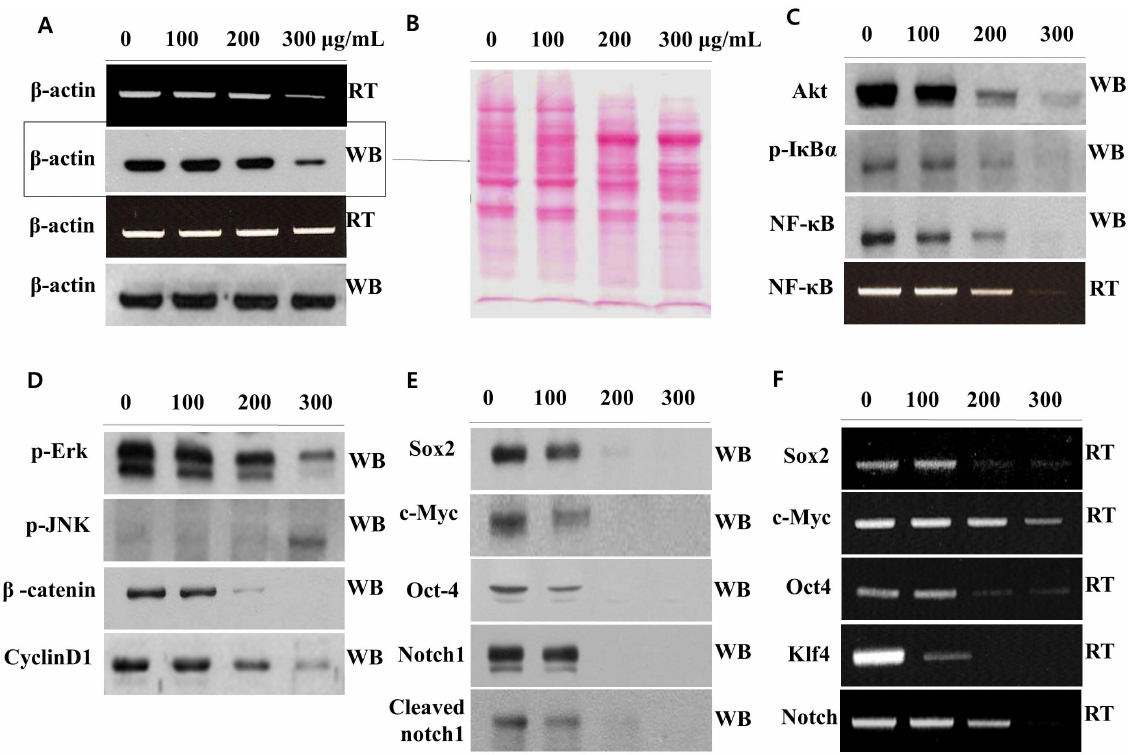
Figure 5. Western blot analysis. Cells were grown for 48 h after MOL treatment and their protein expression levels were measured. (A) b -actin expression. (B) Ponceau S solution staining. (C)–(F) Expression levels of different proteins.